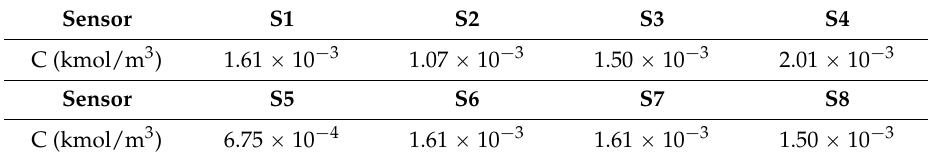
Table 13. The measured concentration of deployment scheme based on WGABC algorithm.